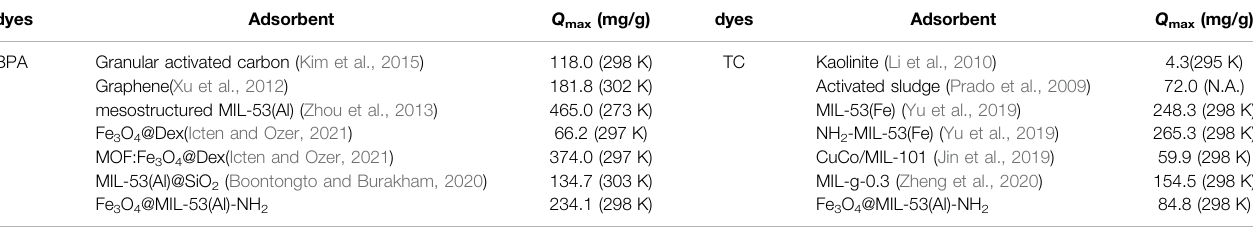
TABLE 4 | Comparison of BPA and TC Adsorption Capacity of Fe 3 O 4 @MIL-53(Al)-NH 2 with Other Adsorbents (mg g − 1 ). dyes